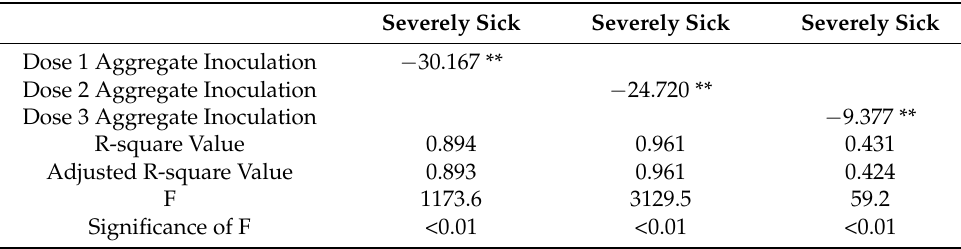
Table 8 indicates that the aggregate number of people inoculated by dose 1 explains 89.4% of the variance in the severely sick patients. Dose 2 accounts for 96% of the variance in the severely sick people. Dose 3 accounts for 43% of the variance in the severely sick people. Table 8. Regression between the severely sick patients and doses 1, 2, and 3.